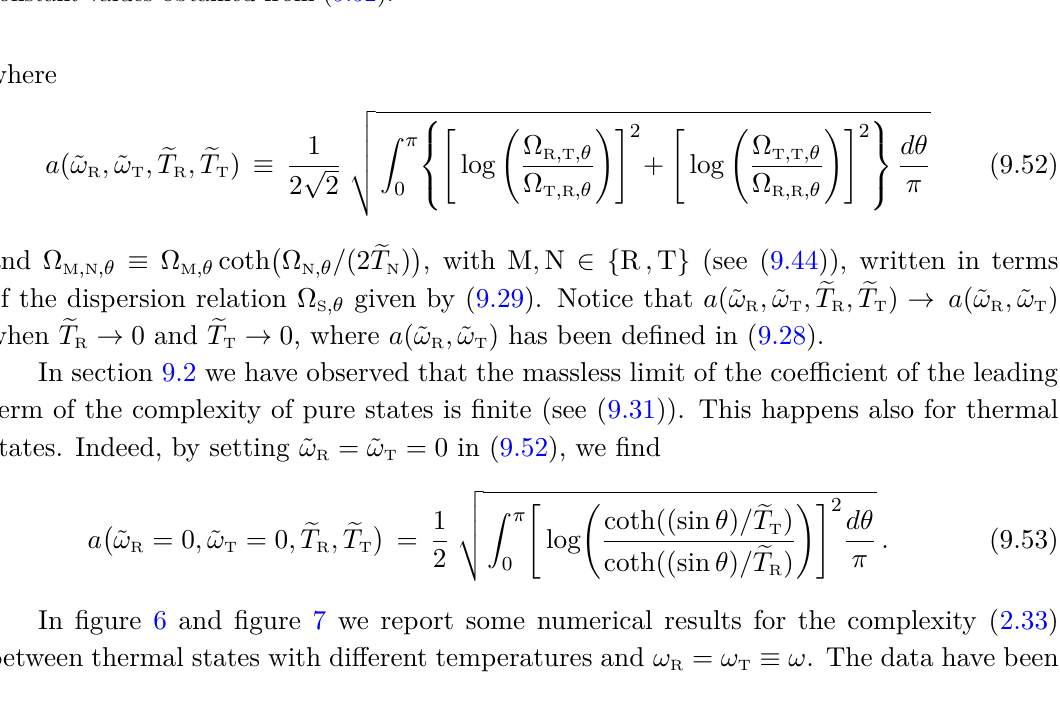
Figure 6 . The complexity C 2 for thermal states as function of the size L of the periodic harmonic chain. Here κ = 1 and m = 1 ; hence ˜ ω the panels T = 0 and various values of T R and ω = ω = 10 − 2 (right). The solid lines correspond to (9.51). Bottom panels: subleading R T term log C 2 − 1 log L as function of log L , for T 2 ω = ω = 1 and ω = ω = 10 − 2 in the right panel. The horizontal solid lines correspond to the R T R T constant values obtained from